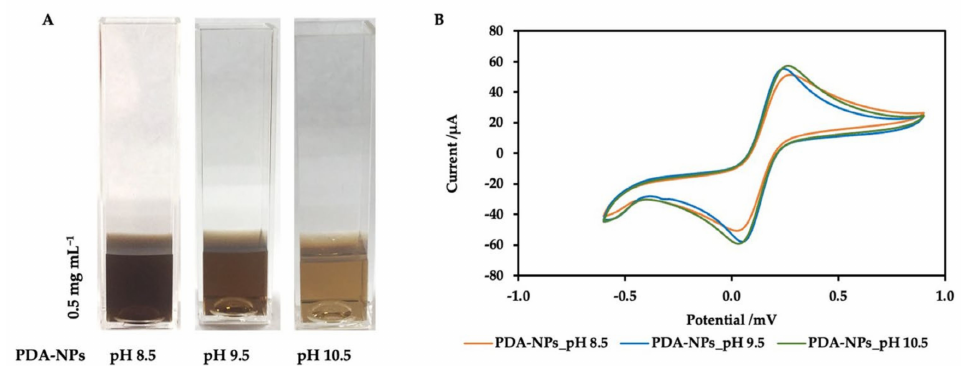
Figure 4. ( A ) PDA-NPs solution synthesized under different pH conditions. ( B ) Cyclic voltammo- grams of SPCEs modified with PDA-NPs synthesized at different pH.